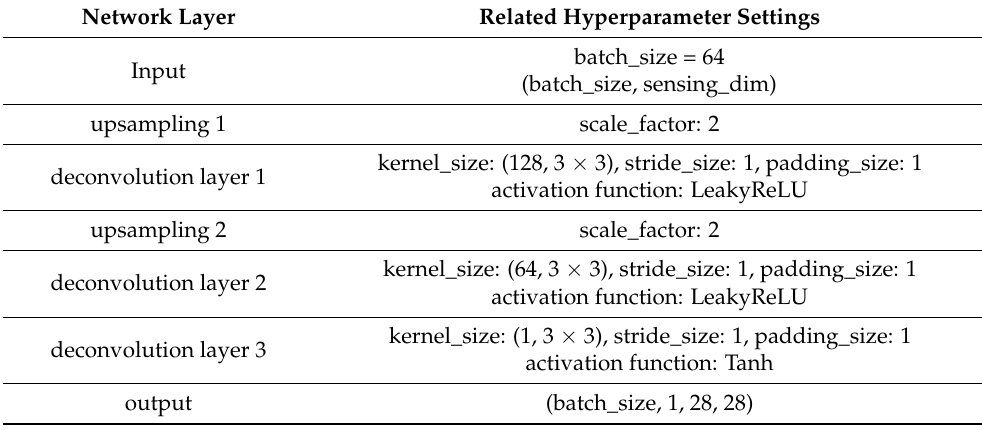
Table 4. Hyperparameter Settings of deconvolution generative model. Network Layer Related Hyperparameter Settings